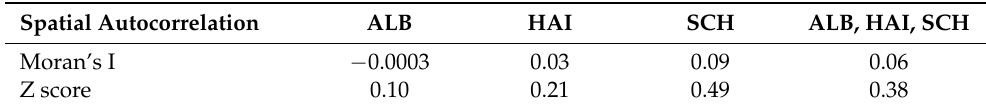
Table 5. Moran’s I result for tree species diversity across the three exploratories. For z-score values between ± 1.65 random distribution of samples can be assumed.